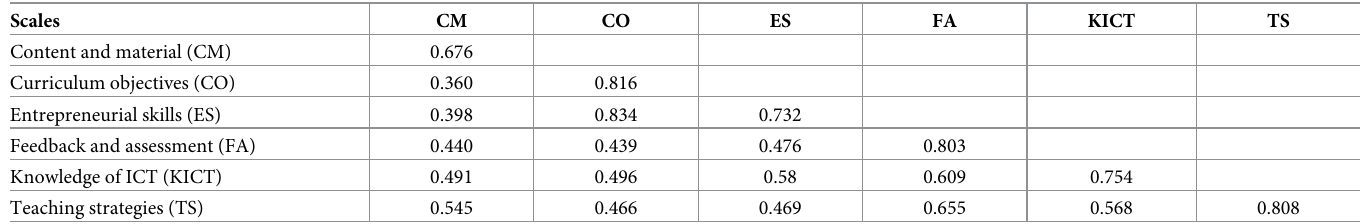
Table 3. Discriminant validity